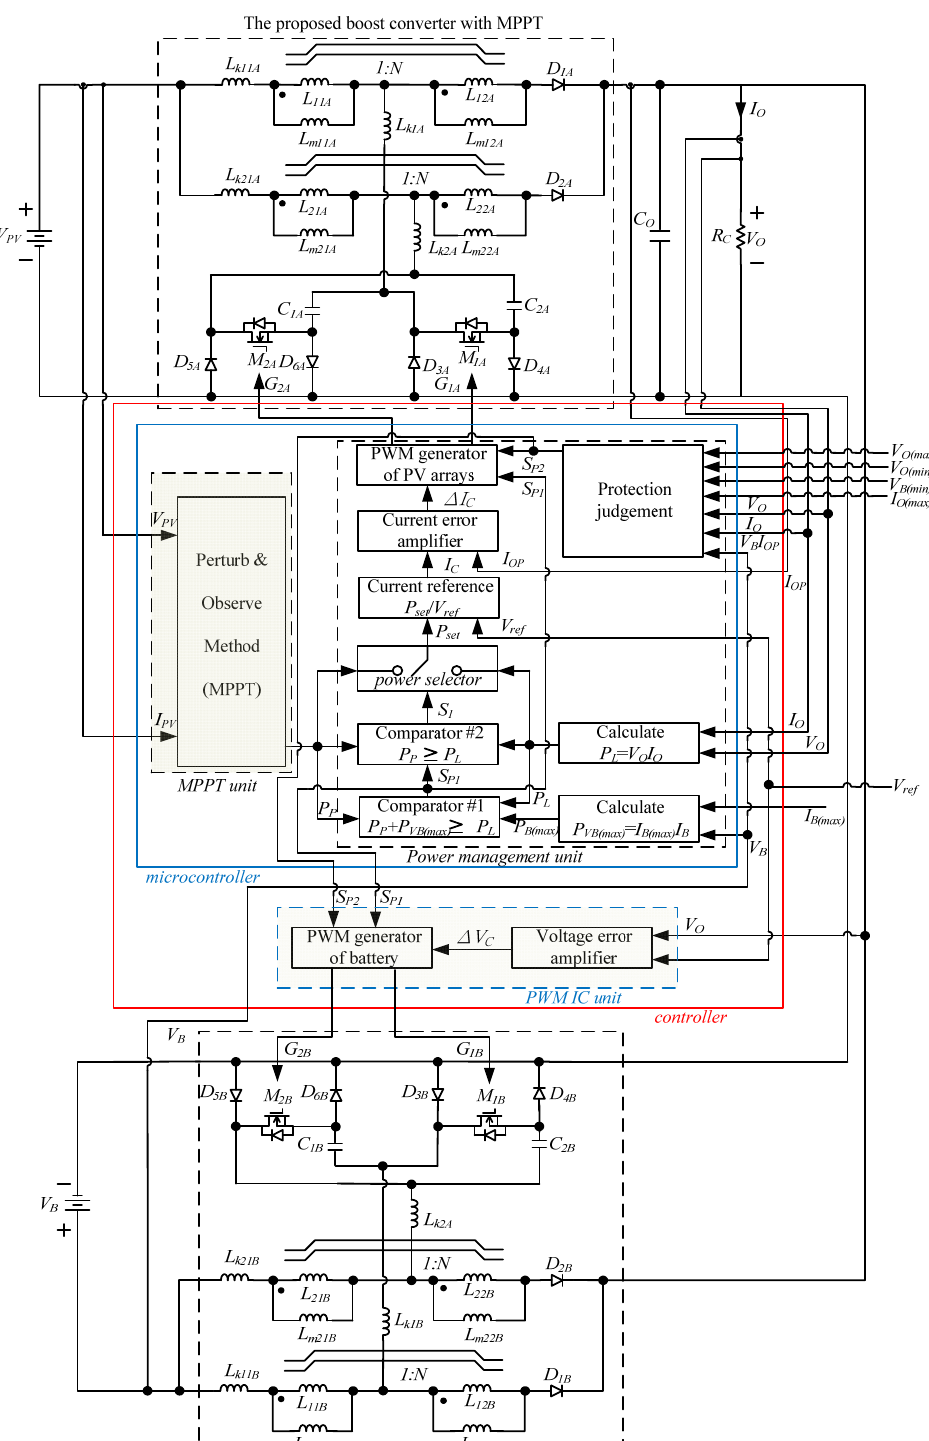
Figure 13. Block diagram of the proposed PV power